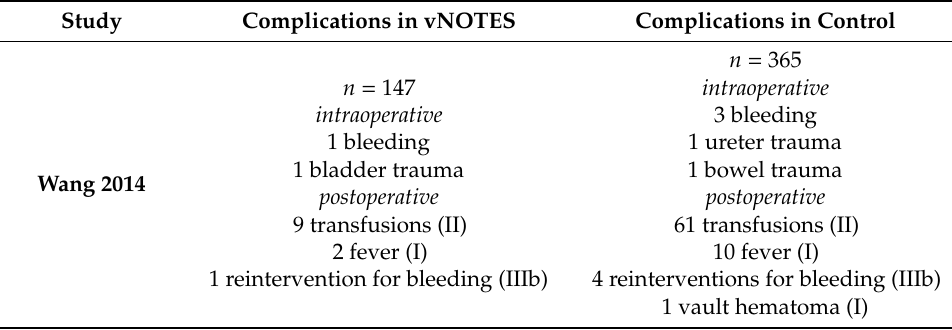
Table 3. Summary of complications in the individual